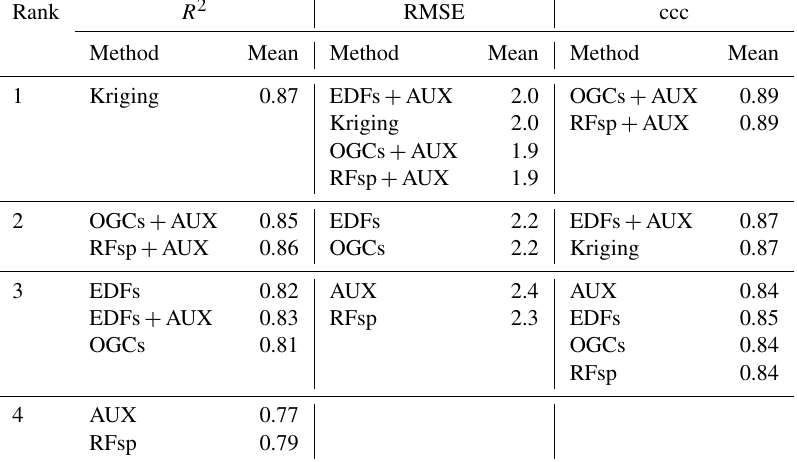
Table 2. Ranks for the accuracies of the methods on the Vindum dataset calculated as Pearson’s R 2 , RMSE and ccc, respectively. Methods for which a pairwise t test did not give a significant difference in accuracy ( p > 0 . 05) received equal ranks for the metric in question. Ranks for the methods therefore differ between the three metrics. AUX – auxiliary data; EDFs – Euclidean distance fields; OGCs – oblique geographic coordinates; and RFsp – distances between